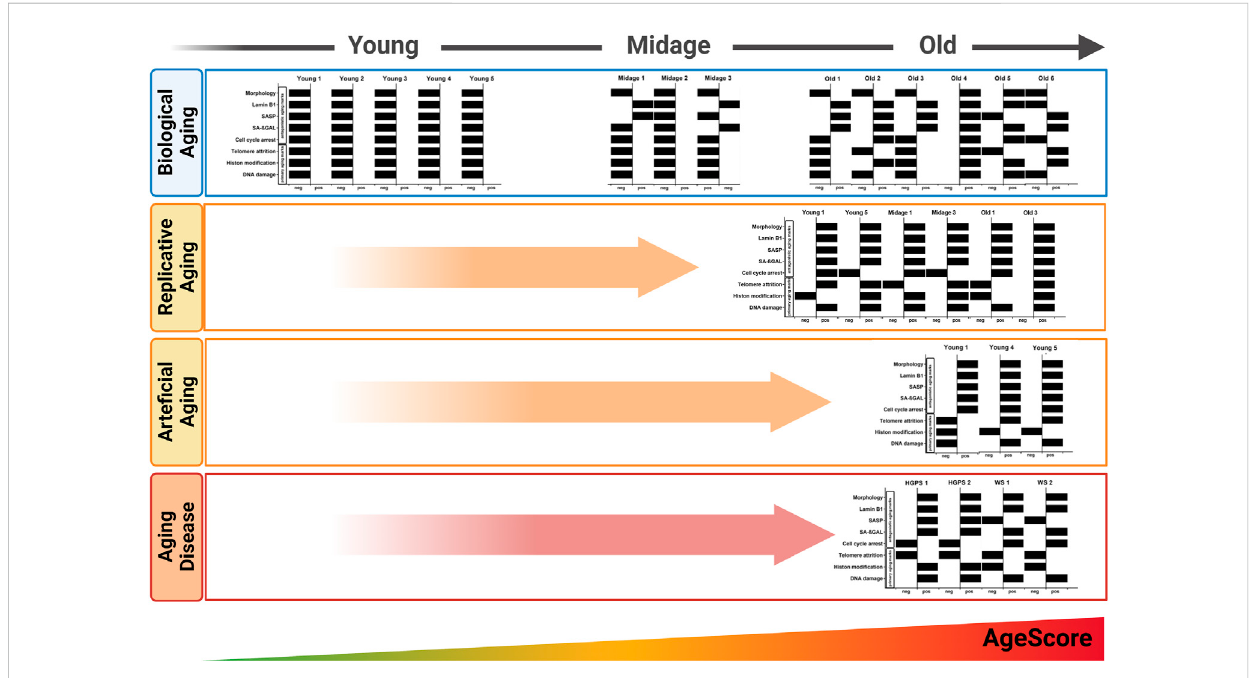
FIGURE 7 PatternoftheAgeScore.ThepatternoftheAgeScorebetweenyoungandolddonors( invivo aging)increasinglyshiftstothepositivesidedepending on the age of the donor. The pattern of in vivo aging is similar to that of replicative and arti fi cial aging. Here, a very strong shift to the positive test side occurs.Thepatternofthe invivo agingprocessdiffersfromthepatternoftheprogeriadiseases,butastrongchangeandanincreaseoftheAgeScorecan be observed.